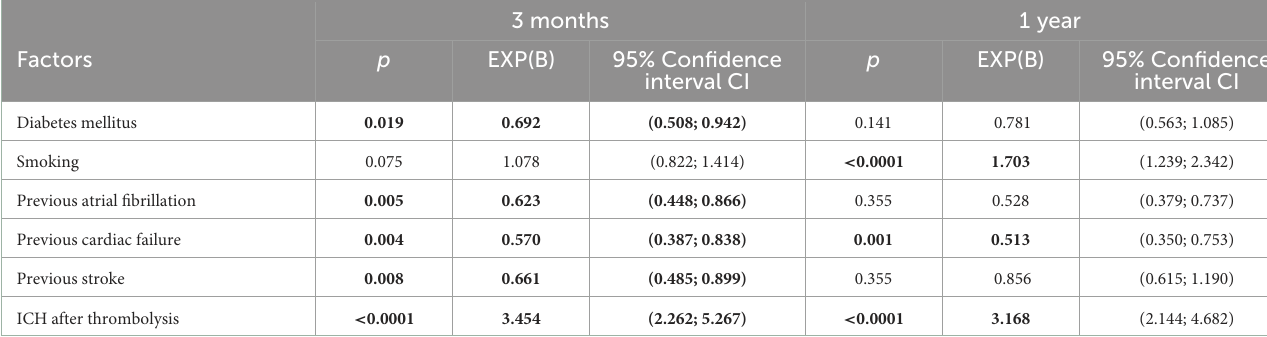
TABLE 4 Factors that have a significant effect on the outcome (poor outcome means mRS > 2 points) at 3 months and at 1 year with the logistic regression